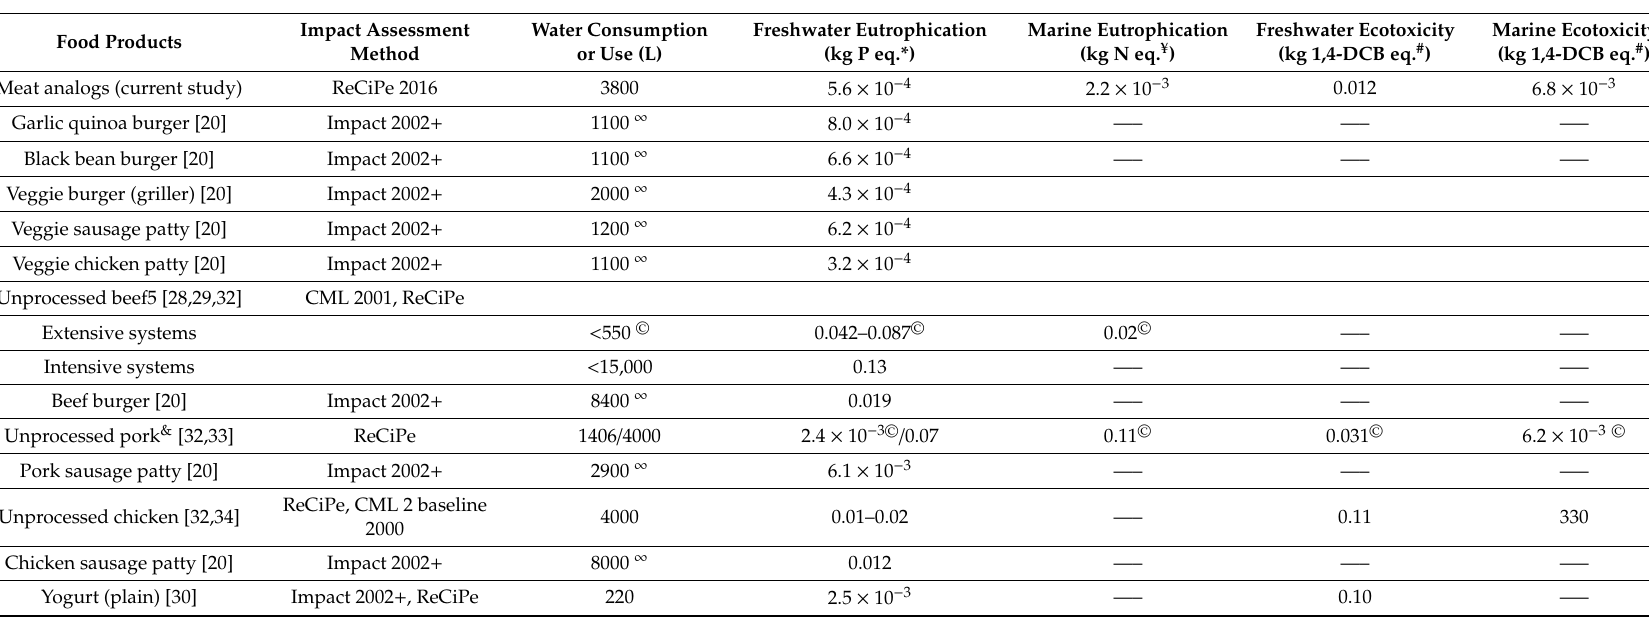
Table 3. Five life cycle assessment indicators associated with generating one kilogram (as the functional unit) of the products